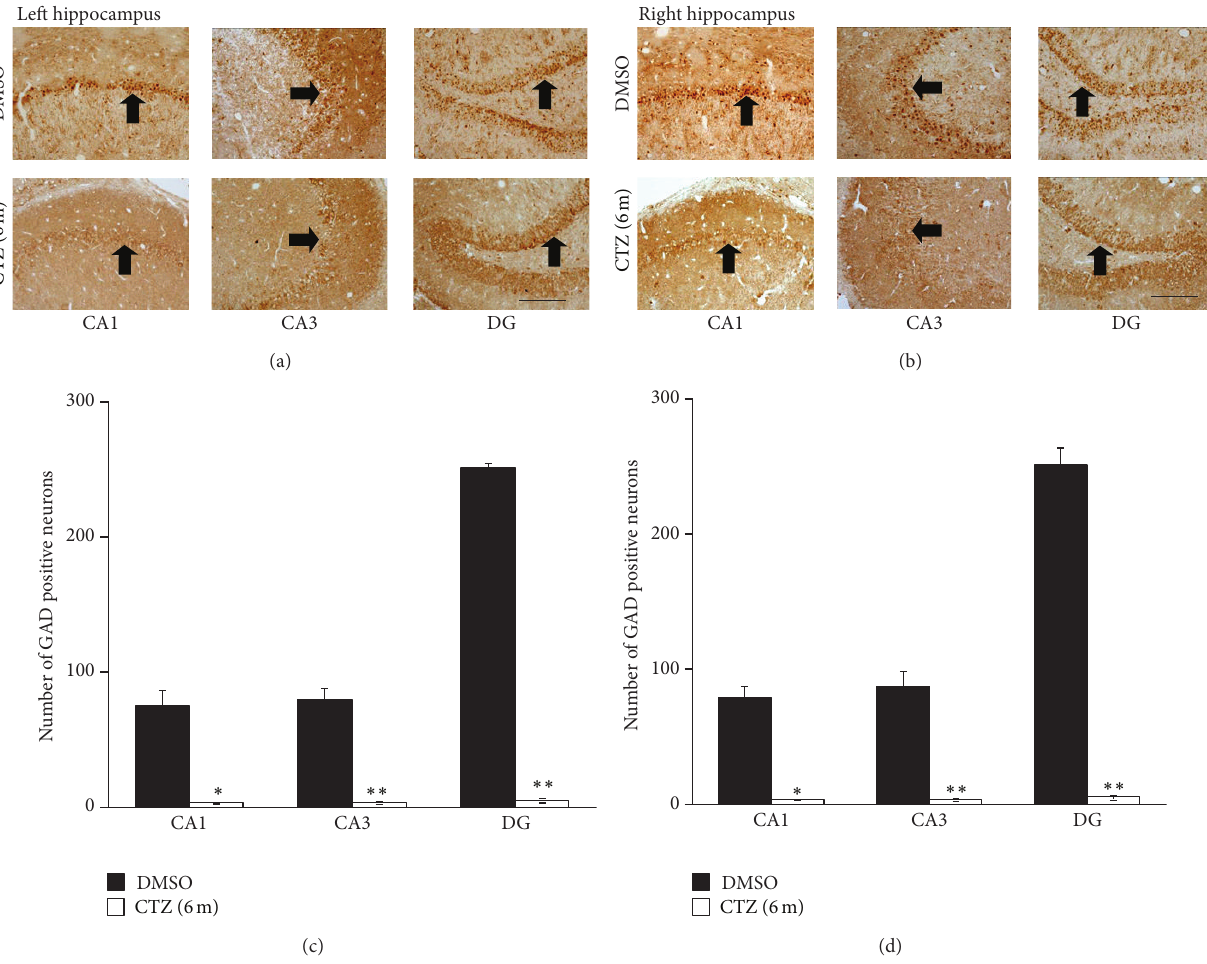
Figure 4: Decreased GAD staining in hippocampus of recurrent seizure rats 6 months after seizure induction by CTZ. (a-b) Pictures showing GAD positive cells (arrow indicated) in left (a) and right (b) hippocampus from rats 6 months after either DMSO (top) or CTZ (bottom) treatment. (c-d) Group data showing significant decreases of the GAD staining cells in CA1, CA3, and DG area of the hippocampus from rats 6 months after either DMSO ( 𝑛 = 3 ) or CTZ ( 𝑛 = 3 ) treatment. ∗ 𝑃 < 0.05 , ∗∗ 𝑃 < 0.01 compared to the DMSO control group. Scale bar in (a) and (b) = 200 𝜇